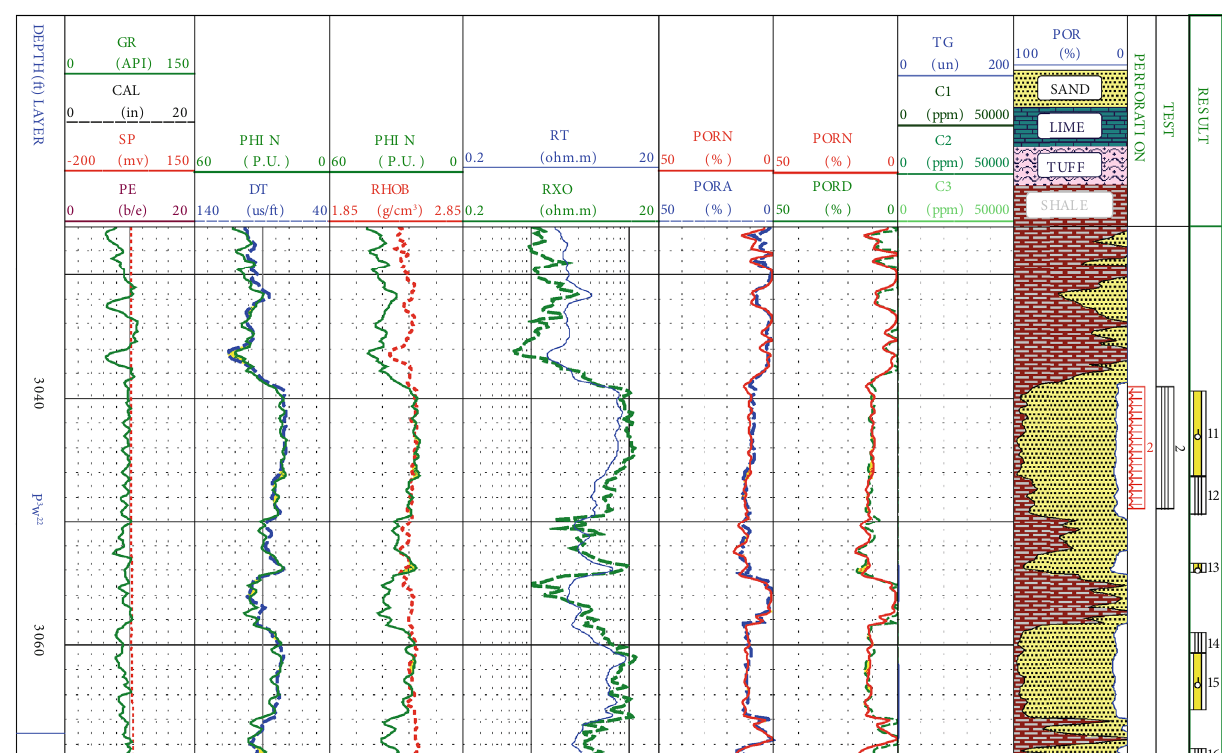
Figure 8: K58025 well logging interpretation